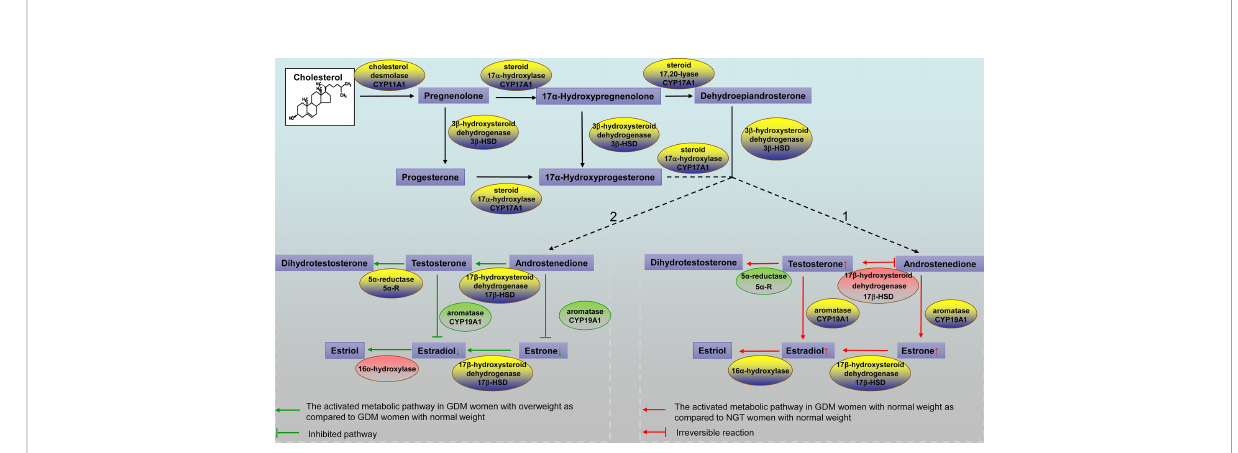
FIGURE 3 Schematic representation of the steroidogenic pathways. Pathway 1. The activated metabolic pathway in GDM women with normal weight compared to NGT women with normal weight is indicated by red arrows. Steroid hormones that showed a higher concentration in GDM women with normal weight are shown in the box with small red arrows. The red box indicates a higher product/precursor ratio in GDM women with normal weight. The green box indicates a lower product/precursor ratio in GDM women with normal weight. Pathway 2. The activated metabolic pathway in GDM women with overweight compared to GDM women with normal weight is indicated by green arrows. Steroid hormones that showed a lower concentration in women with GDM with overweight are shown in the box with small green arrows. The red box indicates a higher product/precursor ratio in GDM women with overweight. The green box indicates a lower product/precursor ratio in GDM women with overweight. GDM, gestational diabetes mellitus; NGT, normal glucose tolerance.